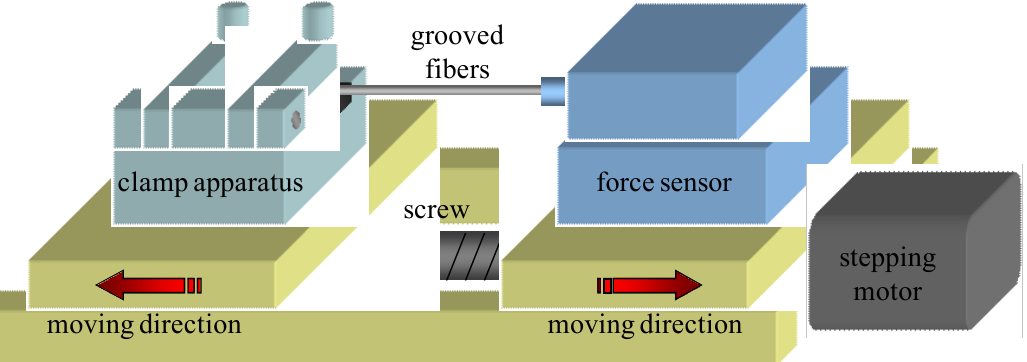
Figure 3. Schematic diagram of the tensile test